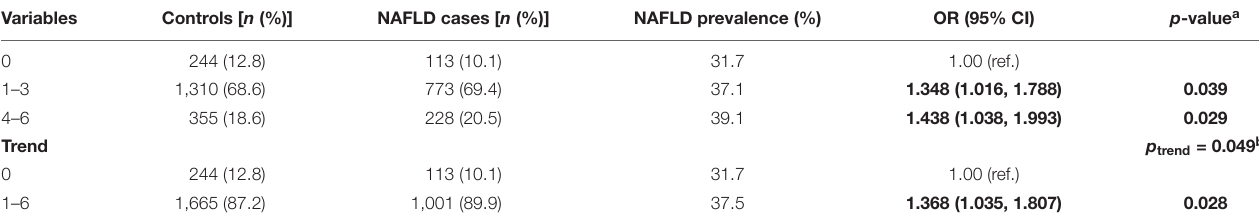
TABLE 3 | Combined effects of rs2296241-A, rs2248359-T, and rs4646536-T on NAFLD risk.